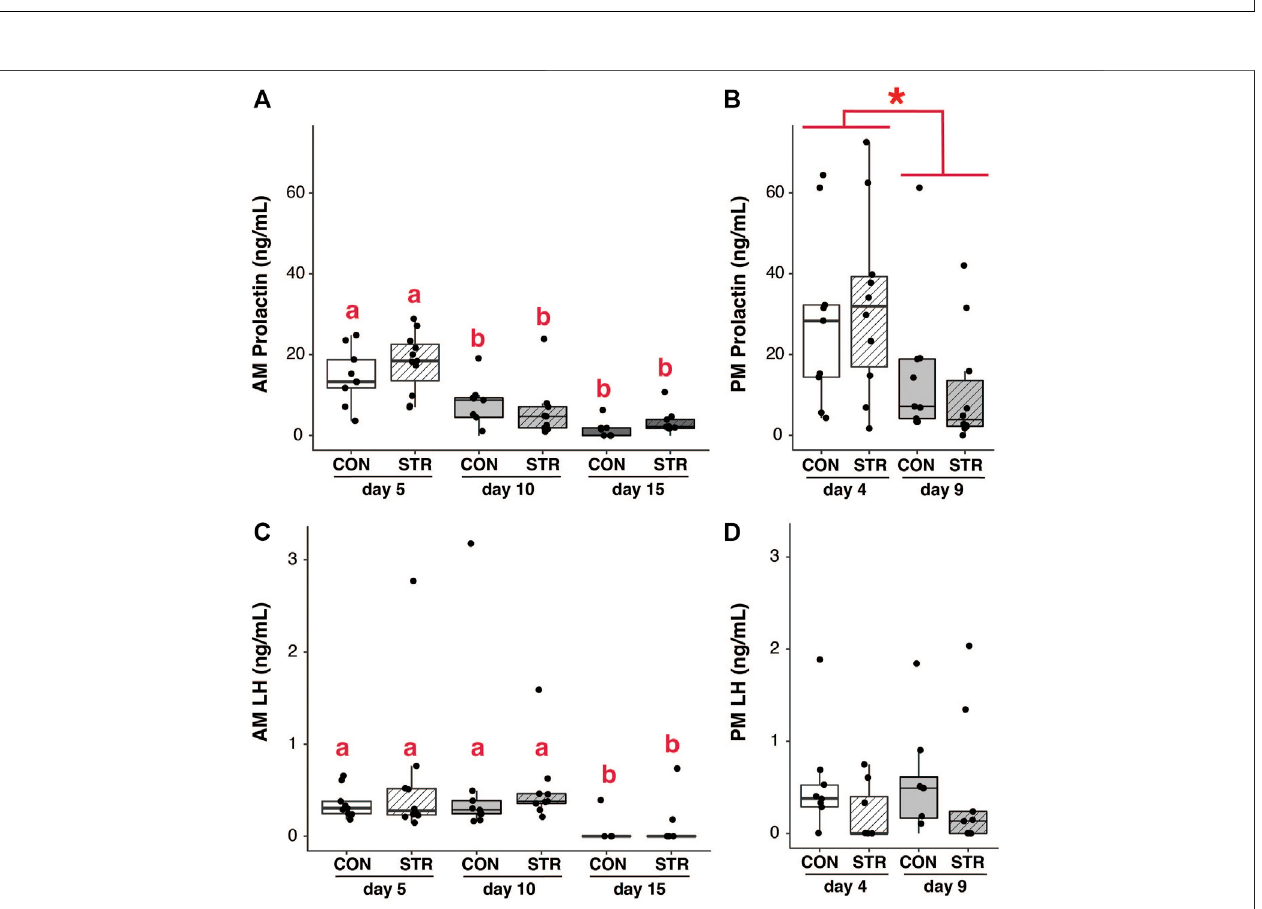
FIGURE 4 | Circulating pituitary hormones change across pregnancy but are unaffected by chronic stress. (A) Morning circulating prolactin decreased as pregnancyprogressed,butconcentrationsdidnotdifferbetweenchronically-stressedandnon-stressedmiceateitherpregnancystage. (B) Similarpatternswerefound in evening levels ofcirculating prolactin. (C) Circulating morningLH wasunaffected stress,but decreased duringmid-pregnancy (day 15). (D) Circulating evening LHdid not differ among treatments. Asterisks (*) indicate signi fi cant ( p < 0.05) main effects. Different letters indicate signi fi cant differences ( p < 0.05) in post-hoc analyses using the Bonferroni-Holm correction for multiple